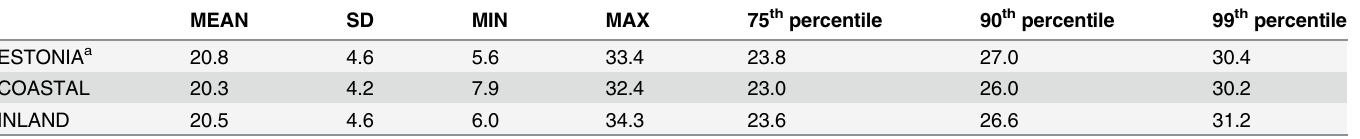
Table 1. Daily maximum temperatures for the summer months over the period 1997 – 2013 per region.